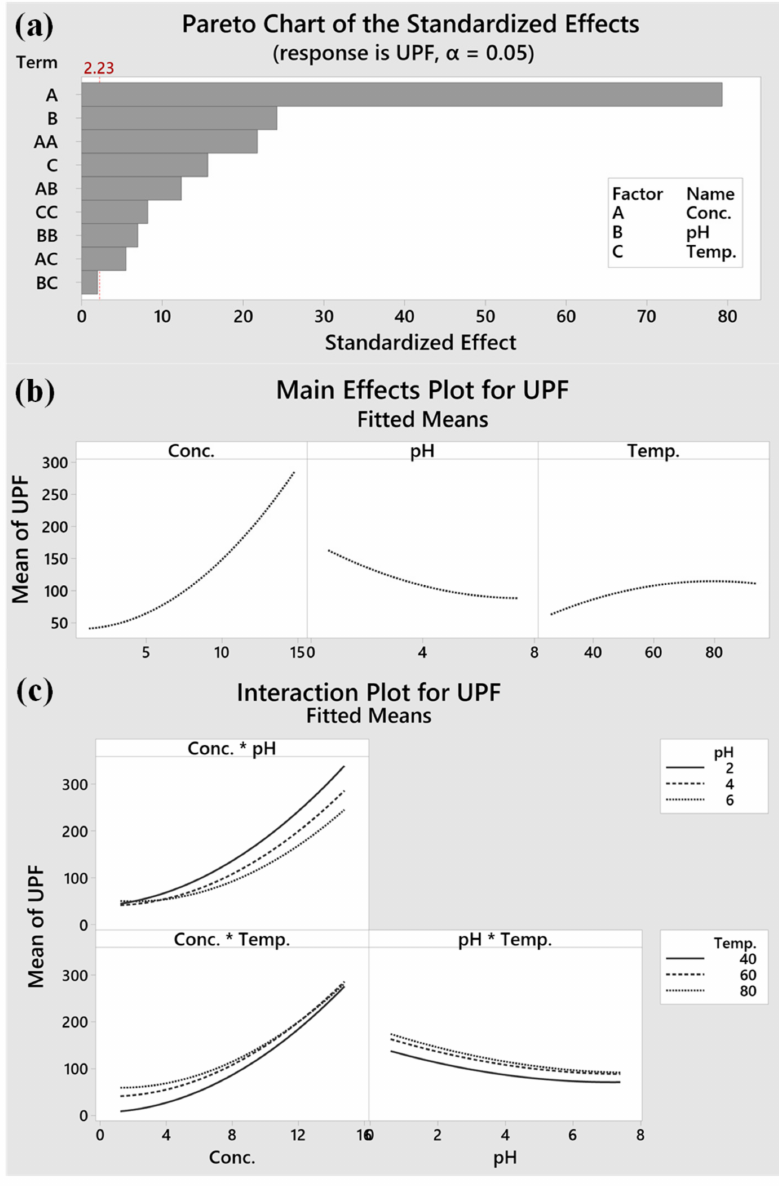
Figure 6. ( a ) Pareto chart, ( b ) Main effects, and ( c ) Interaction